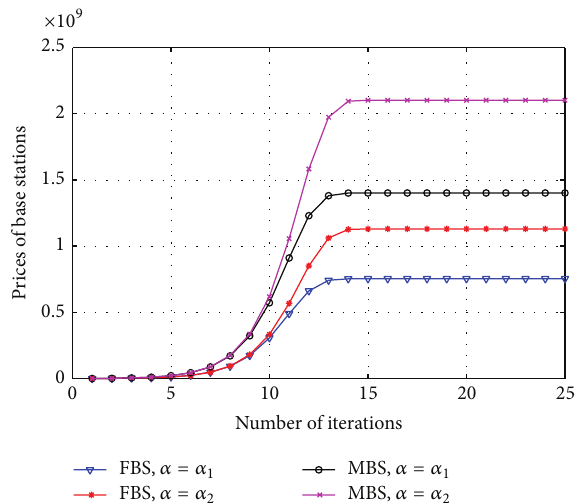
Figure 3: Power of D2D transmitter under different 𝛼